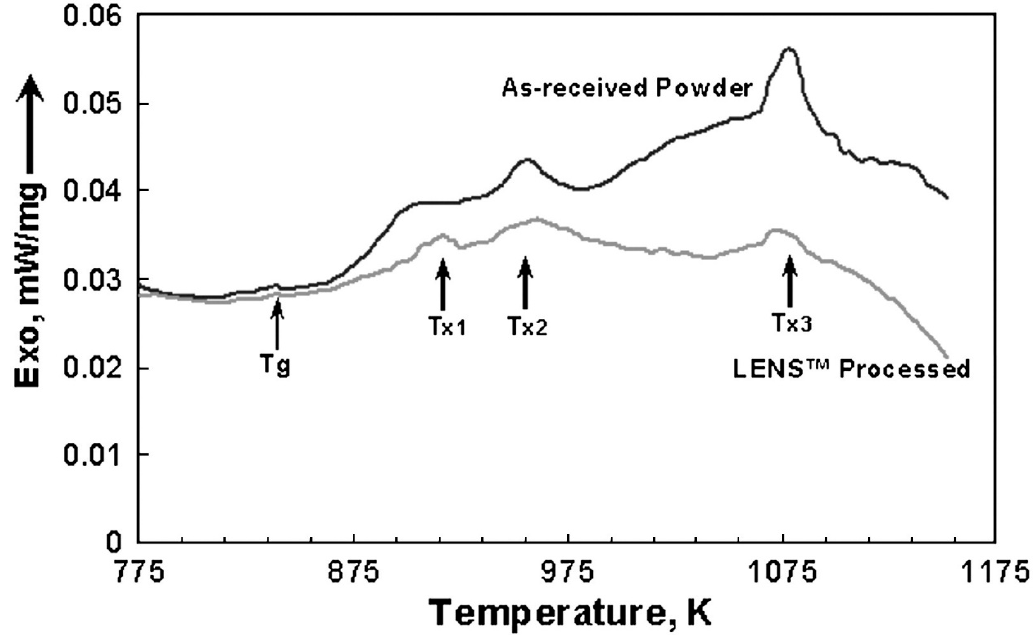
Figure 17. Differential scanning calorimetry (DSC) curves of the feedstock powder and the 3D-printed NSSHS7574 alloy, depicting three crystallisation peaks with three-stage crystallisation behaviour, reprinted with the permission from [80], Elsevier, 2010 ( T g is glass transition temperature and T x1 , T x2 and T x3 are crystallisation temperatures, showing that the material undergoes a three-stage crystallisation process upon heating).